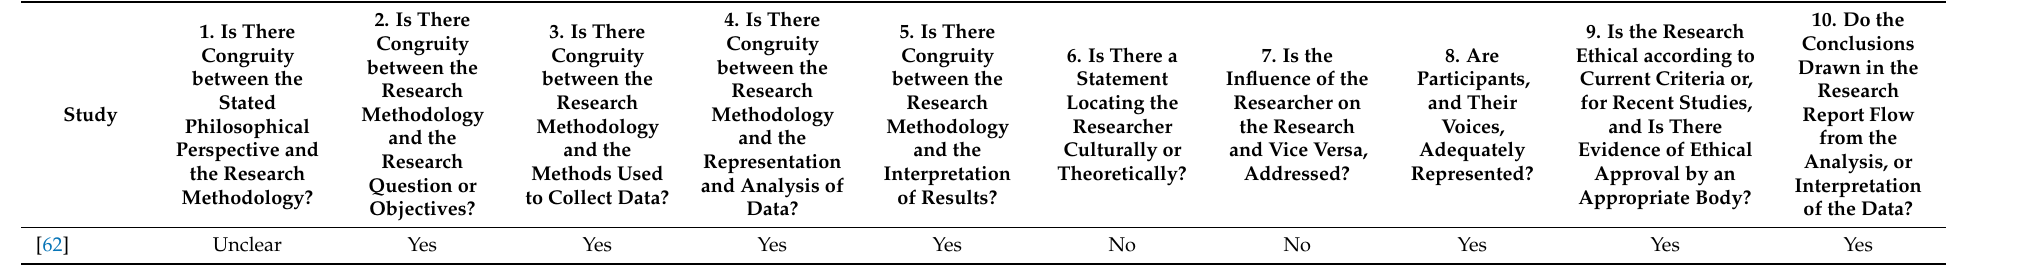
Table 2. Assessment of methodological quality of qualitative